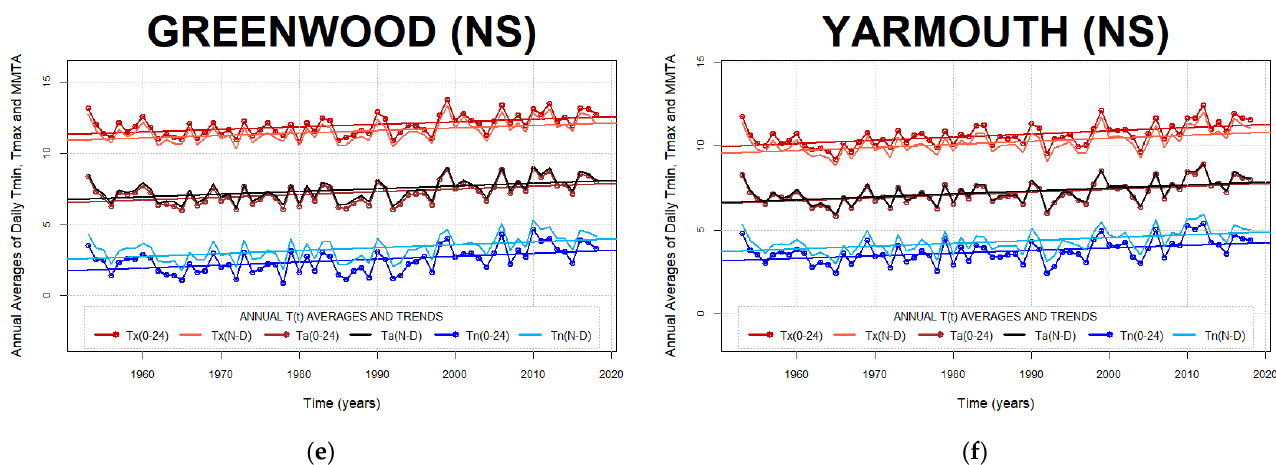
Figure A11. Atlantic Canada climate region. Effect of the observing window on long-term air temperature averaging at St John’s ( a ), Charlottetown ( b ), Fredericton ( c ), Moncton ( d ), Greenwood ( e ), and Yarmouth ( f ) stations. Annually averaged diurnal air temperature minima, maxima, and Min-Max averages obtained with COW 0–24 and COW N–D air temperature approximating methods.